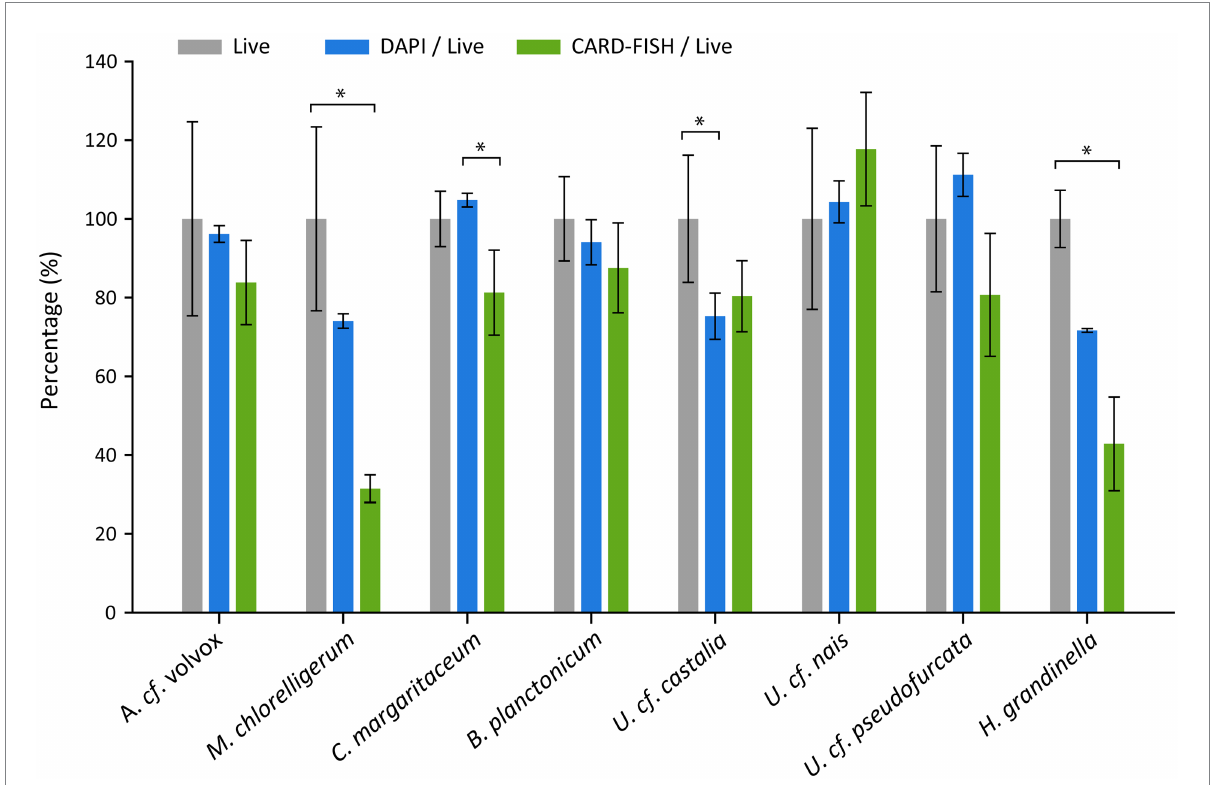
FIGURE 4 Live counts (grey, set to 100%) compared to those of DAPI (blue) and CARD-FISH (green) for eight ciliate species. H. grandinella was hybridized with its genus-specific probe, all other ciliates with their species-specific probe (Tables 1,2). Error bars show standard deviations and stars (*) indicate significant differences between methods ( p < 0.05). Absolute cell abundances of the same treatments are shown in Supplementary Figure